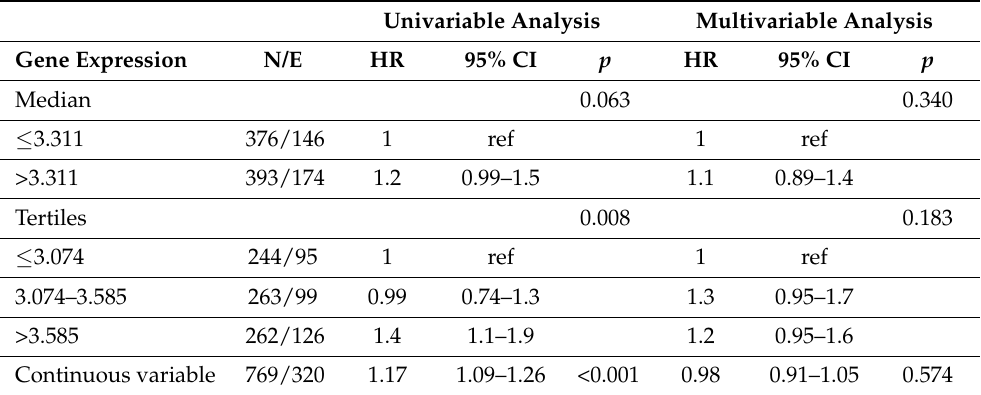
Table 24. Event Free Survival of 769 NB patients in relation to NBAS expression levels evaluated by the Cox regression